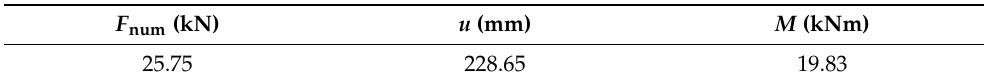
Figure 25. Experiment B: Load – deformation curves of quasi-static numerical modeling for individual specimens made from fully threaded screws. Figure 26 shows the overall deformation of the connection, including the defor- mation of the auxiliary steel structure. This deformation describes the actual behavior of the entire structure during loading.